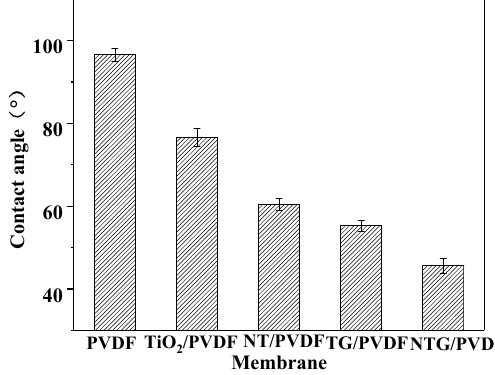
Figure 5. The water contact angle of the membrane.